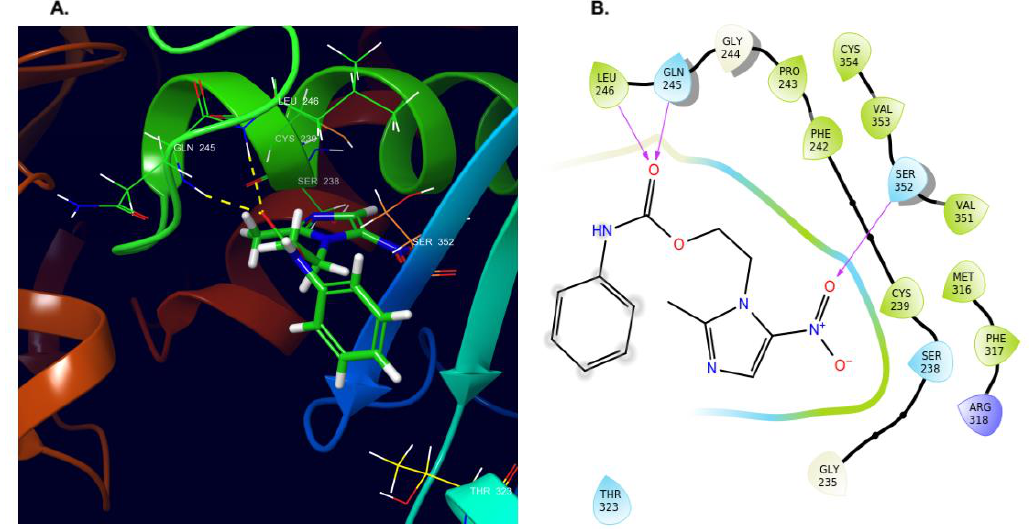
Figure 3. ( A ) 3D and ( B ) 2D representations of the binding model of compound 2 in the vicinity of colchicine binding site of β -tubulin.